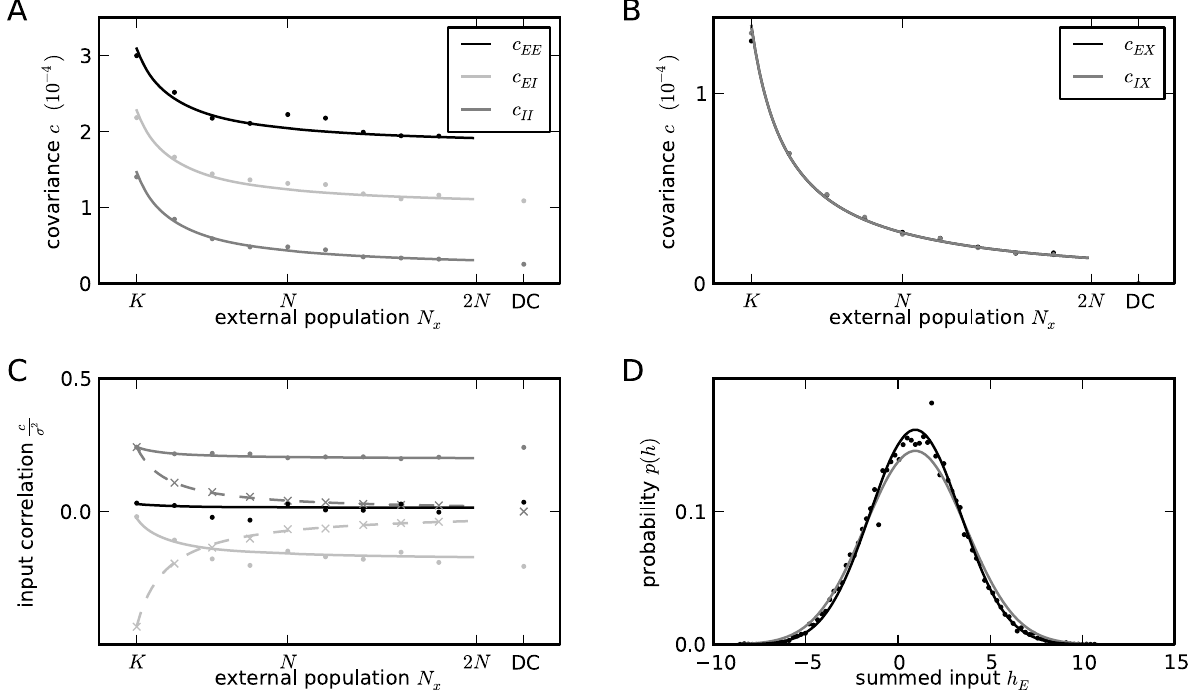
Figure 3. Correlations in a network of three populations as illustrated in Figure 2 in dependence of the size N x of the external 5 population. Each neuron in population a [ f E , I g receives pN randomly drawn excitatory inputs with weight J a E ~ ffiffiffiffiffi N p , pN randomly drawn 10 ~ 5 inhibitory inputs of weight J a I ~{ ffiffiffiffiffi N p and pN external inputs of weight J a X ffiffiffiffiffi N p (homogeneous random network with fixed in-degree, connection probability p ~ 0 : 2 ). A Correlations averaged over pairs of neurons within the local network (22). Dots indicate results of direct simulation over T ~ 30s averaged over ( N = 2) 2 pairs of neurons. Curves show the analytical result (24). The point ‘‘ DC ’’ shows the correlation structure emerging if the drive from the external population is replaced by a constant value KJ a X m X , which provides the same mean input as the original external drive. B Correlations between neurons within the local network and the external population averaged over pairs of neurons (same labeling as in A). C Correlation between the inputs to a pair of cells in the network decomposed into the contributions due to shared inputs c shared (gray, eq. 25) and due to correlations c corr in the presynaptic activity (light gray, eq. 26). Dashed curves and St. Andrew’s Crosses show the contribution due to external inputs, solid curves and dots show the contribution from local inputs. The sum of all components is shown by black dots and curve. Curves are theoretical results based on (24), (25), and (26), symbols are obtained from simulation. D Probability distribution of the fluctuating input h E to a single neuron in the excitatory population. Dots show the histogram obtained from simulation binned over the interval ½ min( h E ),max( h E ) (cid:2) with a bin size of { 2 J a I . The gray curve is the prediction of a Gaussian distribution obtained from mean-field theory neglecting correlations, with mean and variance given by (4) and (6), respectively. The black curve takes correlations in the afferent signals into account and has a variance given by (13). Other parameters: simulation resolution D t ~ 0 : 1 ms , synaptic delay d ~ D t , activity measurement in intervals of 1 ms . Threshold of the neurons h ~ 1 , time constant of inter-update intervals t ~ 10 ms . The average activity in the network is m E ^ m I ^ m X ~ 0 : 5